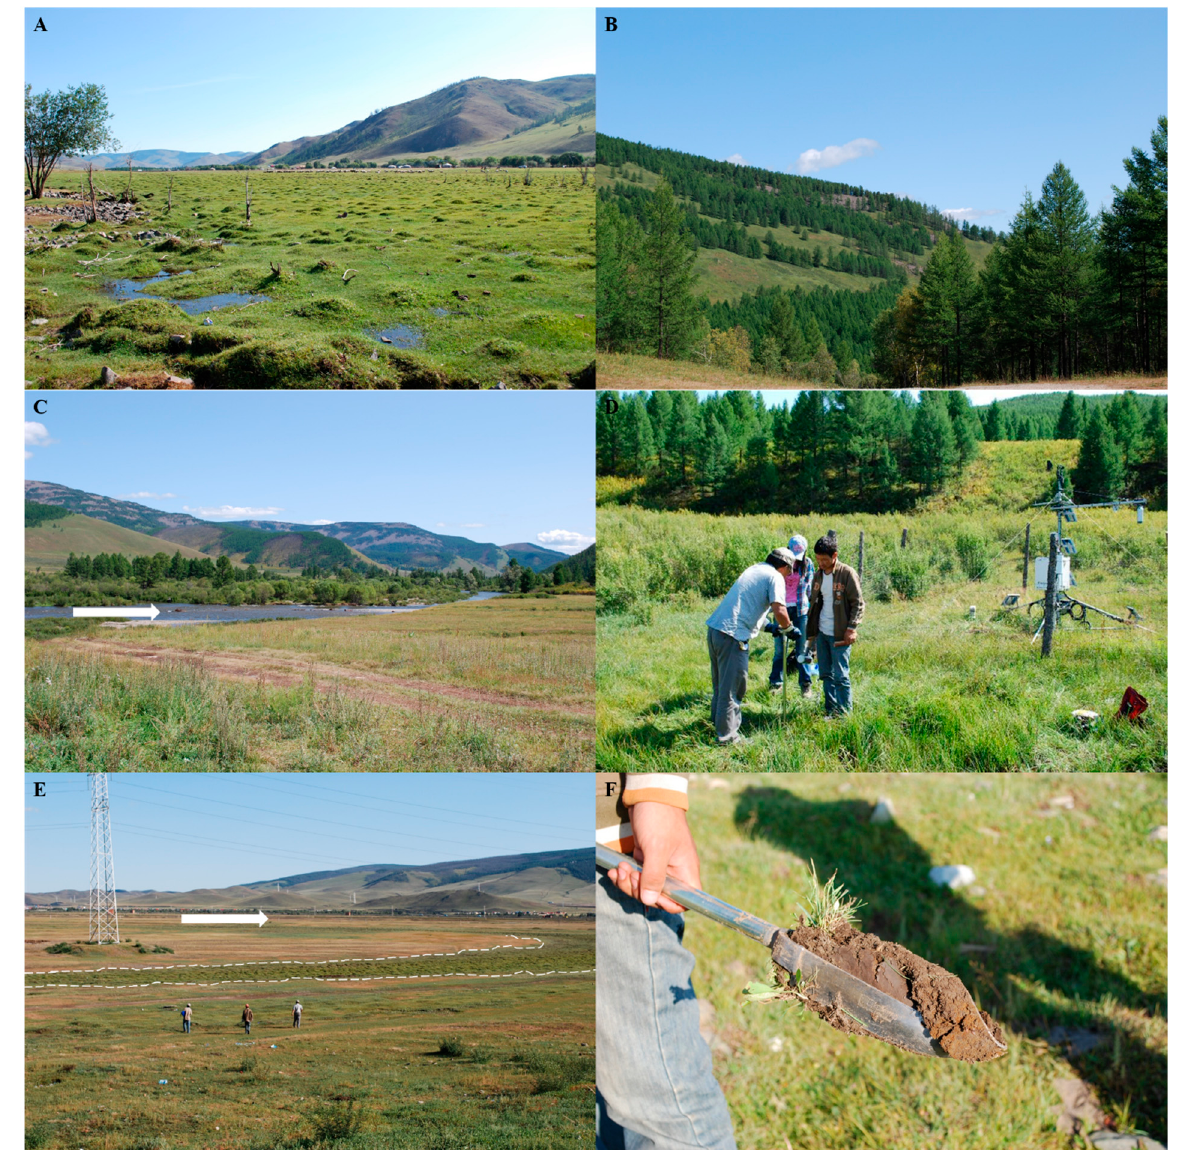
Figure 2. Sampling sites in Khentii Mountain Range. ( A ) The peatland with mounds of seasonal permafrost viewing toward the southwest. ( B ) Mt. Davaat viewing toward the west. ( C ) Terelj River viewing toward the southwest from ( D ), and the arrow indicates the flow direction of Terelj River. ( D ) The sampling of the core TE08 (Figure 1B). ( E ) The peatland with mounds of seasonal permafrost (dashed curve) viewing toward the north, and the arrow indicates the flow direction of Tuul River in the northeast of Mt. Bogd (Figure 1B). ( F ) Surface sediments at the sampling site for the core TU08 (Figure 1B). Photos by A. Orkhonselenge on 20 August 2008.